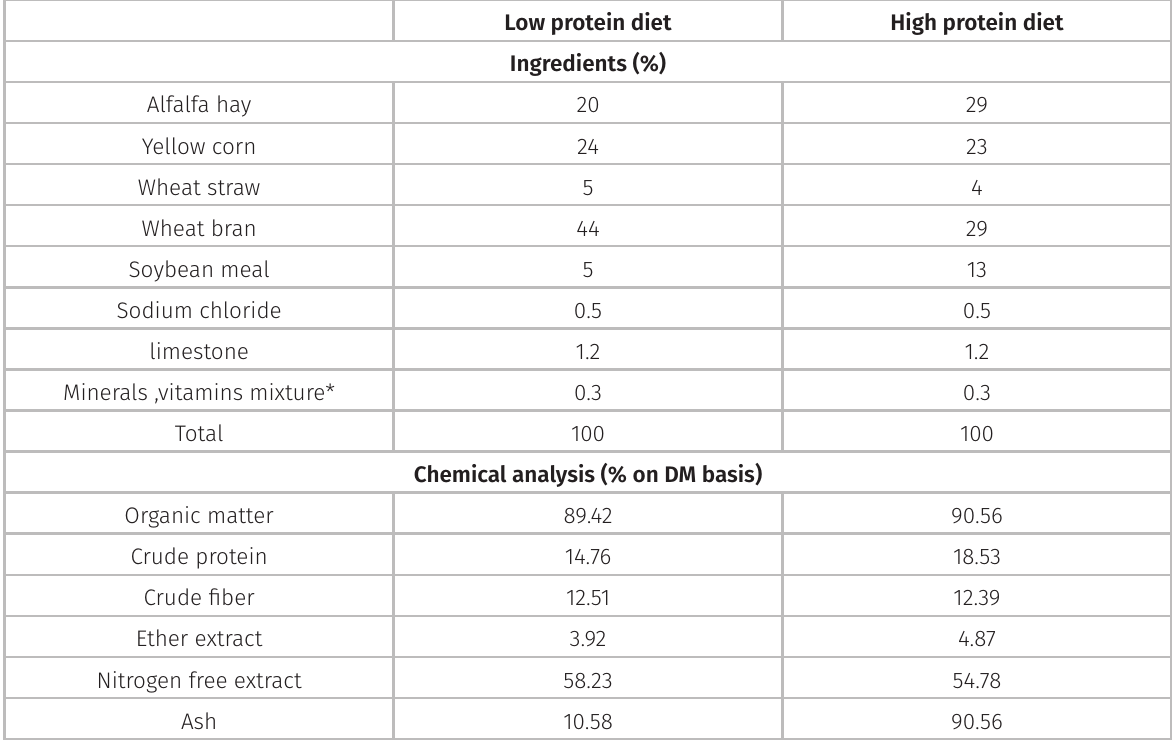
Table I. Formulation and analyzed composition of the basal-diets fed to